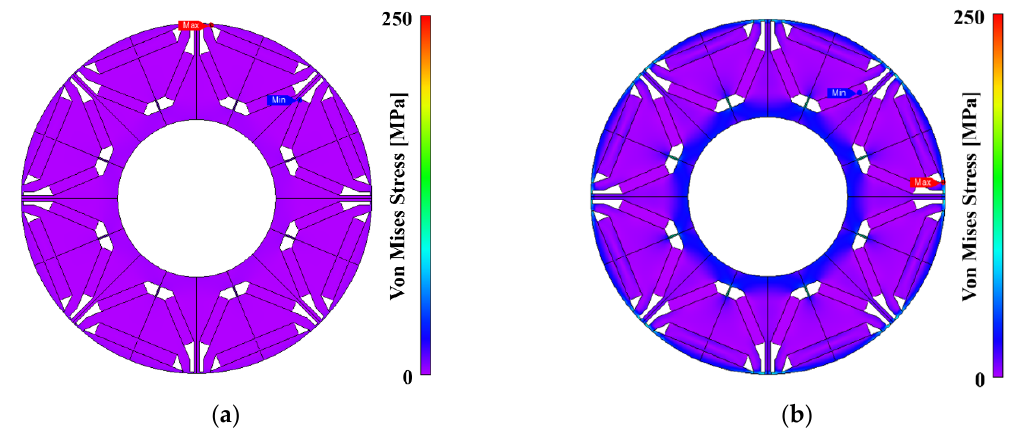
Figure 7. Load condition magnetic flux density contour plot of the optimum model. Table 4. Optimization result and performance comparison of the initial model and optimum model.